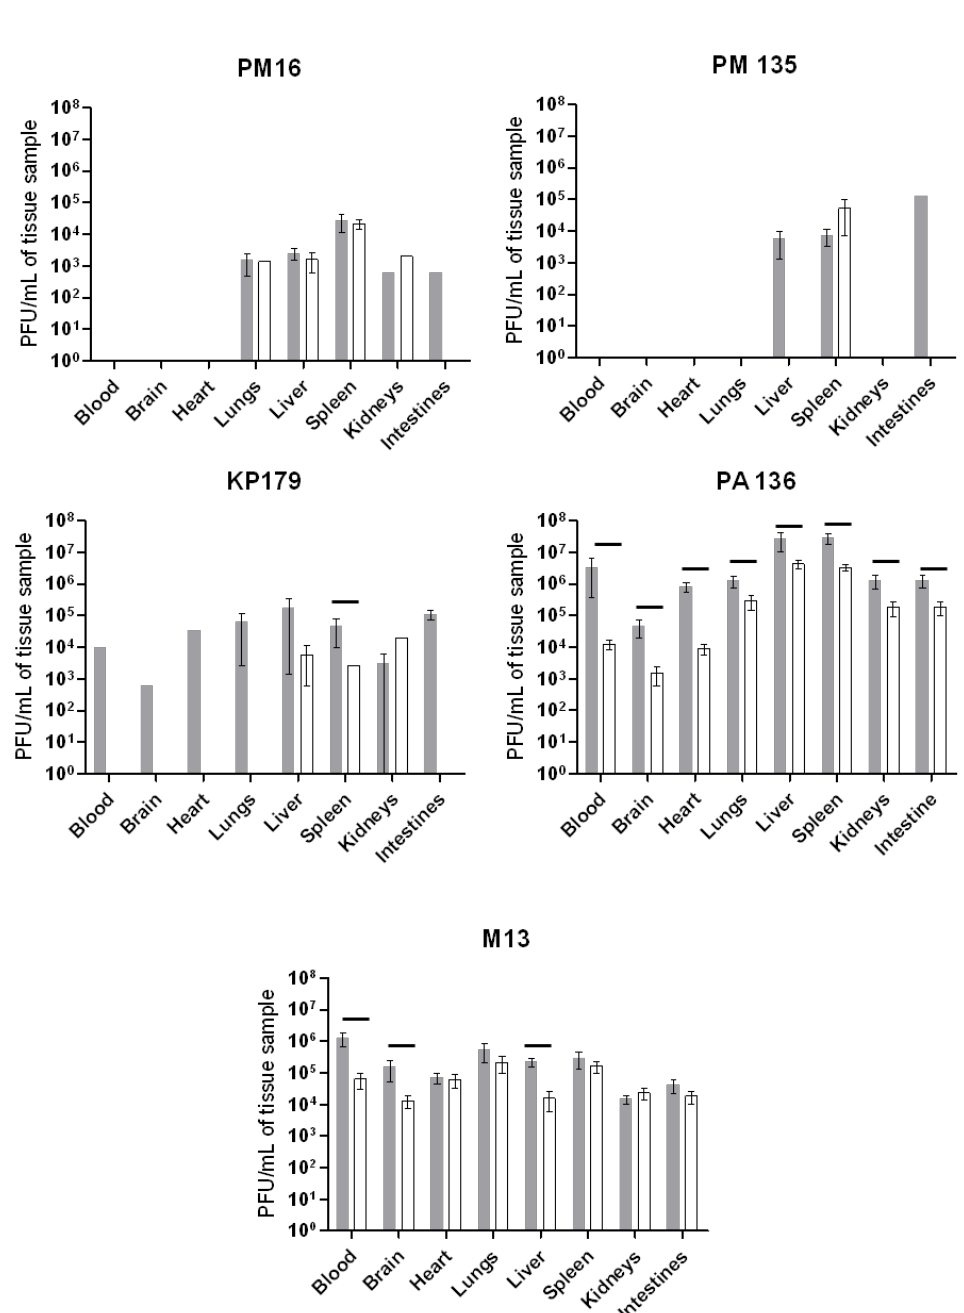
Figure 2. Tissue distribution of phages PM16, PM135, KP179, PA136, or M13 estimated based on their titers. Mice (n = 12 in each group) were once administered an intraperitoneal injection of a selected phage at a target dose of 10 8 PFU per mouse in 100 μL 0.9% NaCl. Blood and tissue samples were taken from six mice from each group six hours after phage injection (grey columns) and 24 h after injection (white columns). Phage titers were determined using a fresh layer of an appropriate bacterial host strain in the top agar. Results are given in mean values ± standard deviation. Horizontal lines indicate statistical significance, p < 0.05.